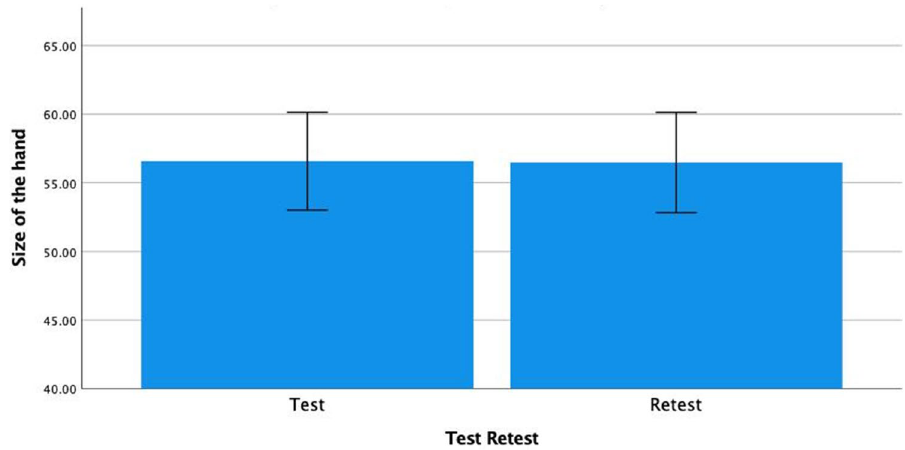
Figure 3. Bar graph of the first and second rating of the size of the hand on a visual analog scale (means and 95% CI of the